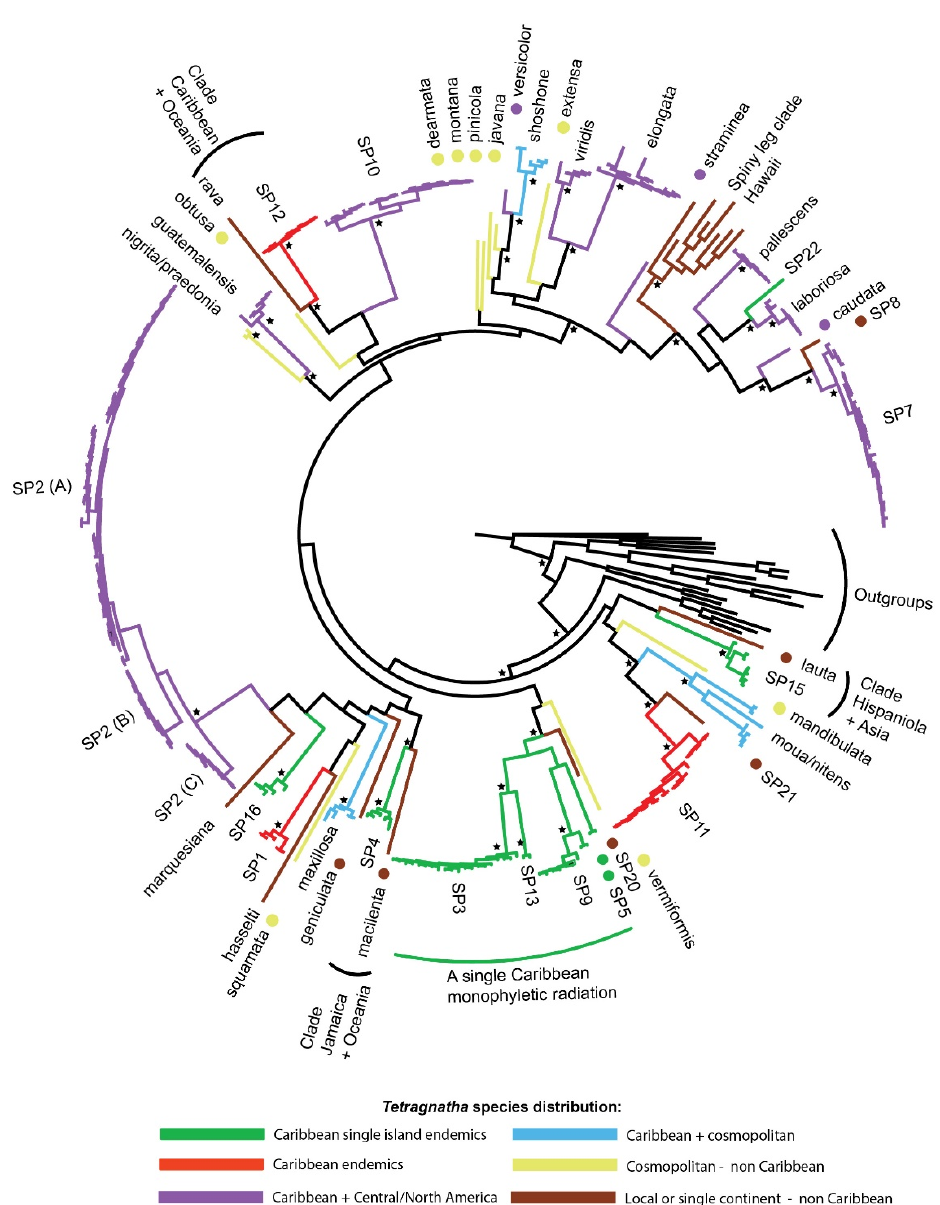
Figure 3. The all-terminal mitochondrial Bayesian phylogeny of the Caribbean and global Tetragnatha representatives. The scattered phylogenetic pattern of single island endemic, Caribbean endemic and cosmopolitan species, as well as highly supported clades of geographically distant relatives reveal a profile of a “dynamic disperser”. Note the non-monophyly of the Caribbean Tetragnatha . Stars at nodes indicate Bayesian posterior probability values > 0.90.